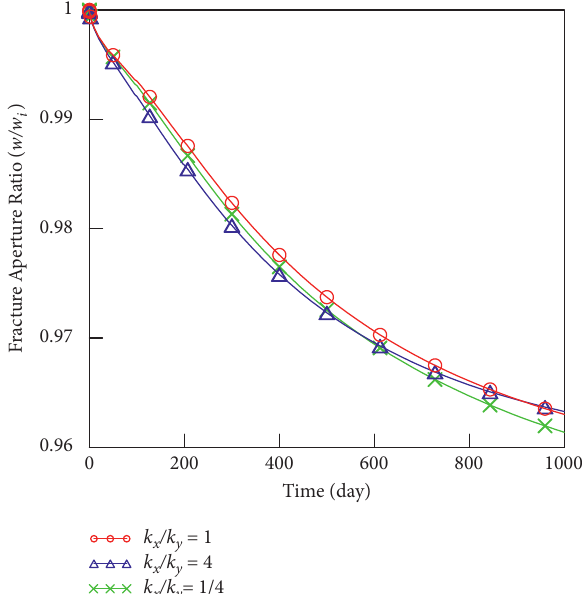
Figure 20: Fracture aperture history for fracture 3.